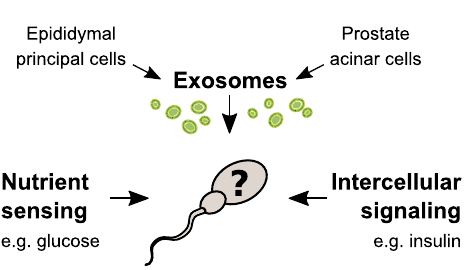
Fig 7. Alternative hypotheses for rapid responses to diet in human sperm. Since endogenous nuclear gene transcription in late-stage spermatozoa is strongly repressed, rapid responses are likely dependent on the activation of latent factors already available within the sperm or on the transfer of critical factors from surrounding somatic cells. Possible mechanisms for latent factor activation involve direct sperm sensing of dietary nutrients present in seminal fluid or intercellular signaling by receptor-ligand binding. Exosomes, which are small extracellular vesicles, known to transfer sncRNA between cells, are candidates for soma-to-sperm transfer of sncRNA such as tsRNA, but also other factors affecting sperm motility. In humans, epididymal principal cells and prostate acinar cells in the male reproductive tract are known to release such exosomes into seminal fluid. Thus, exosome transfer is the only known mechanism that may increase nuclear sncRNA in late-stage sperm by de novo transcription. Transcription of mitochondrial sncRNA in mature sperm is less well understood. sncRNA, small non-coding RNA; tsRNA, tRNA- derived small